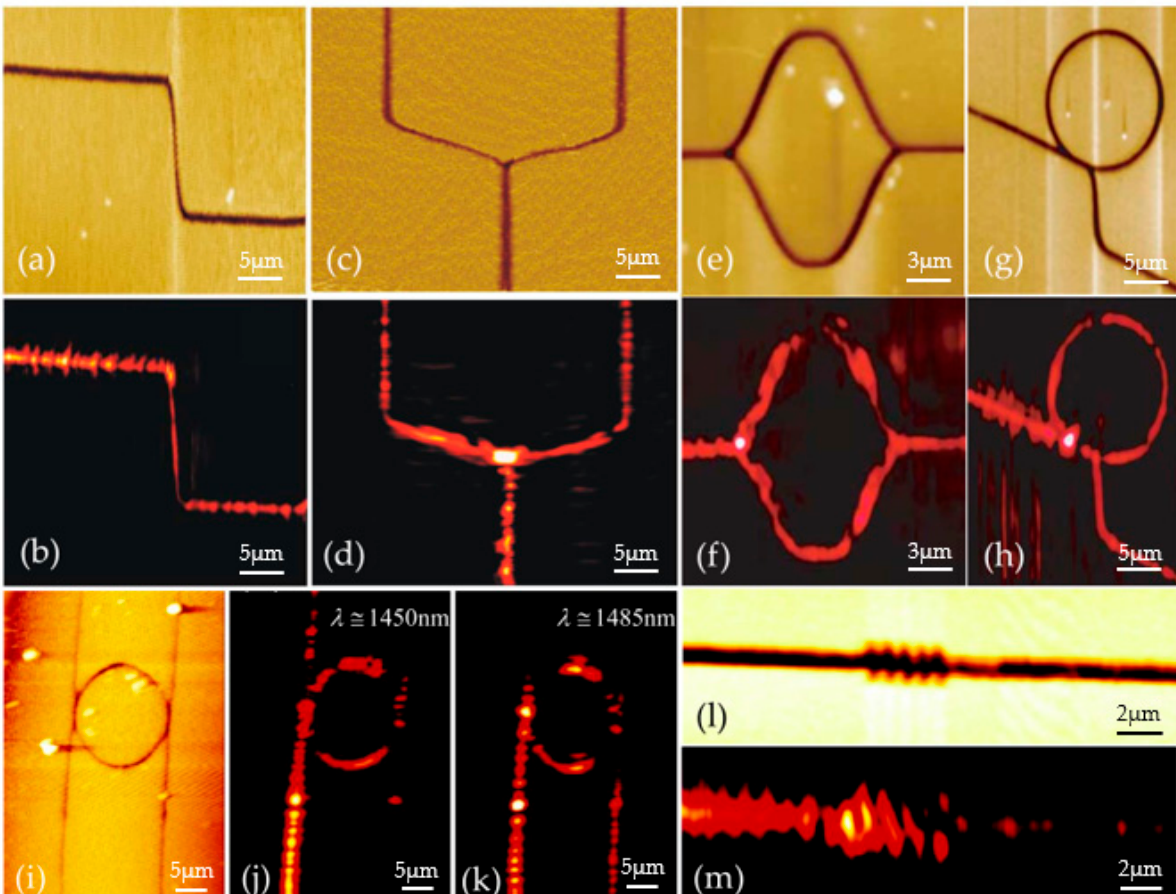
Figure 4. Topographical ( a , c , e , g , i , l ) and near-field optical ( b , d , f , h , j , k , m ) images of plasmonic subwavelength waveguide components. ( a , b ) S-bend [77]. ( c , d ) Y-splitter [77]. ( e , f ) Mach–Zehnder (M.Z.) interferometer [78]. ( g , h ) Waveguide–ring (WR) resonator [78]. ( i – k ) WR-resonator-based add-drop multiplexer [79]. ( l , m ) Bragg grating filter (BGF) [79]. Figures reproduced from ( a – d ) [77]; ( e – h ) [78]; ( i – m ) [79].